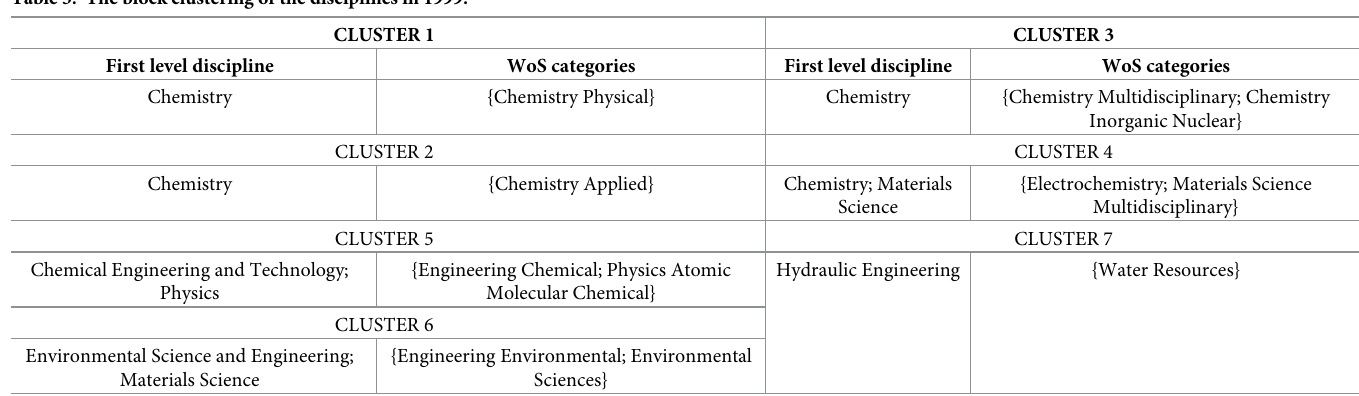
Table 5. The block clustering of the disciplines in 1999.